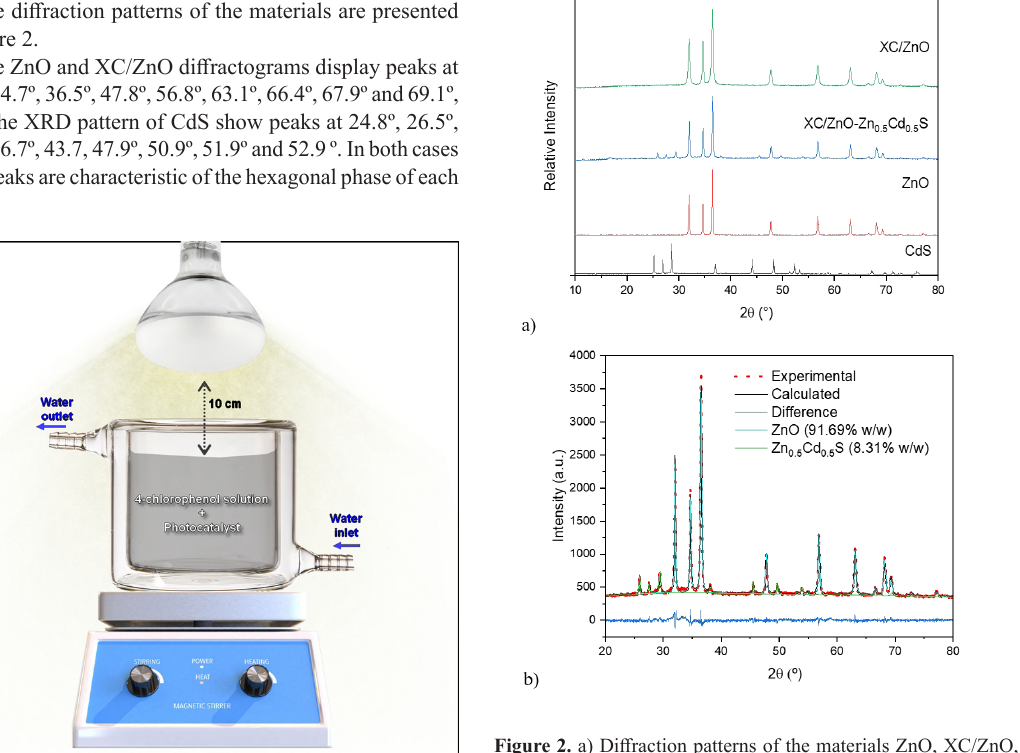
Figure 2. a) Diffraction patterns of the materials ZnO, XC/ZnO, CdS, and XC/ZnO-Zn Cd S; b) Rietveld refinement of the XC/ 0.5 0.5 ZnO-Zn Cd S 0.5 0.5